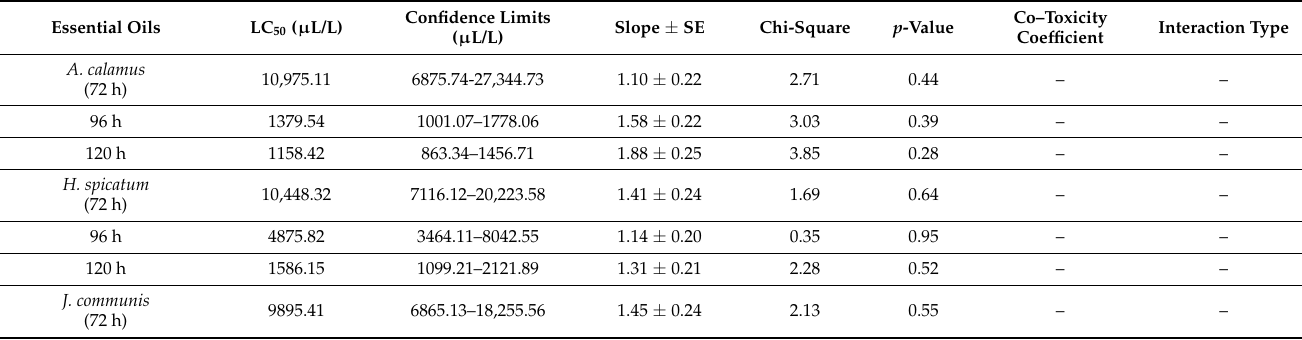
Table 3. Toxicity of different essential oils and their combinations against C. chinensis .